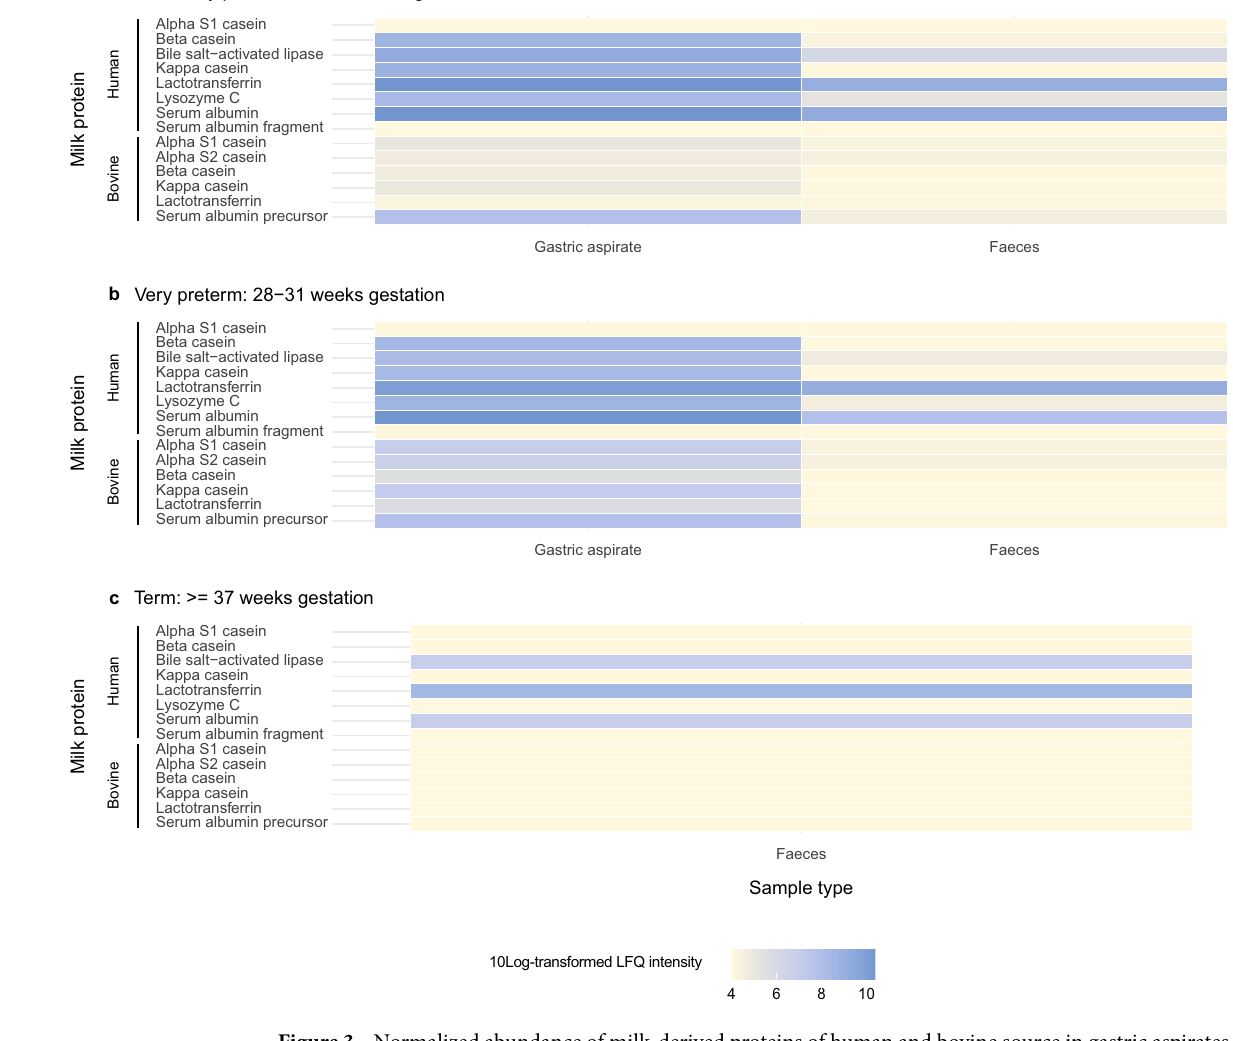
Figure 3. Normalized abundance of milk-derived proteins of human and bovine source in gastric aspirates and feces during the first two postnatal weeks. Milk-derived proteins in gastric aspirates and feces of ( a ) extremely preterm, ( b ) very preterm and ( c ) term infants. Log10 transformed LFQ values are shown. Coloring is based on abundance from least abundant (yellow) to most abundant